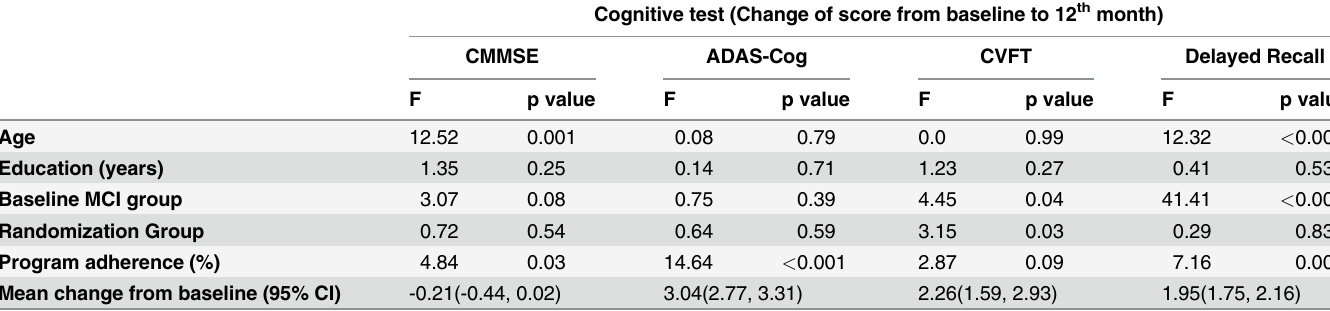
Table 6. Factors associated with changes in cognitive scores from baseline to 12th